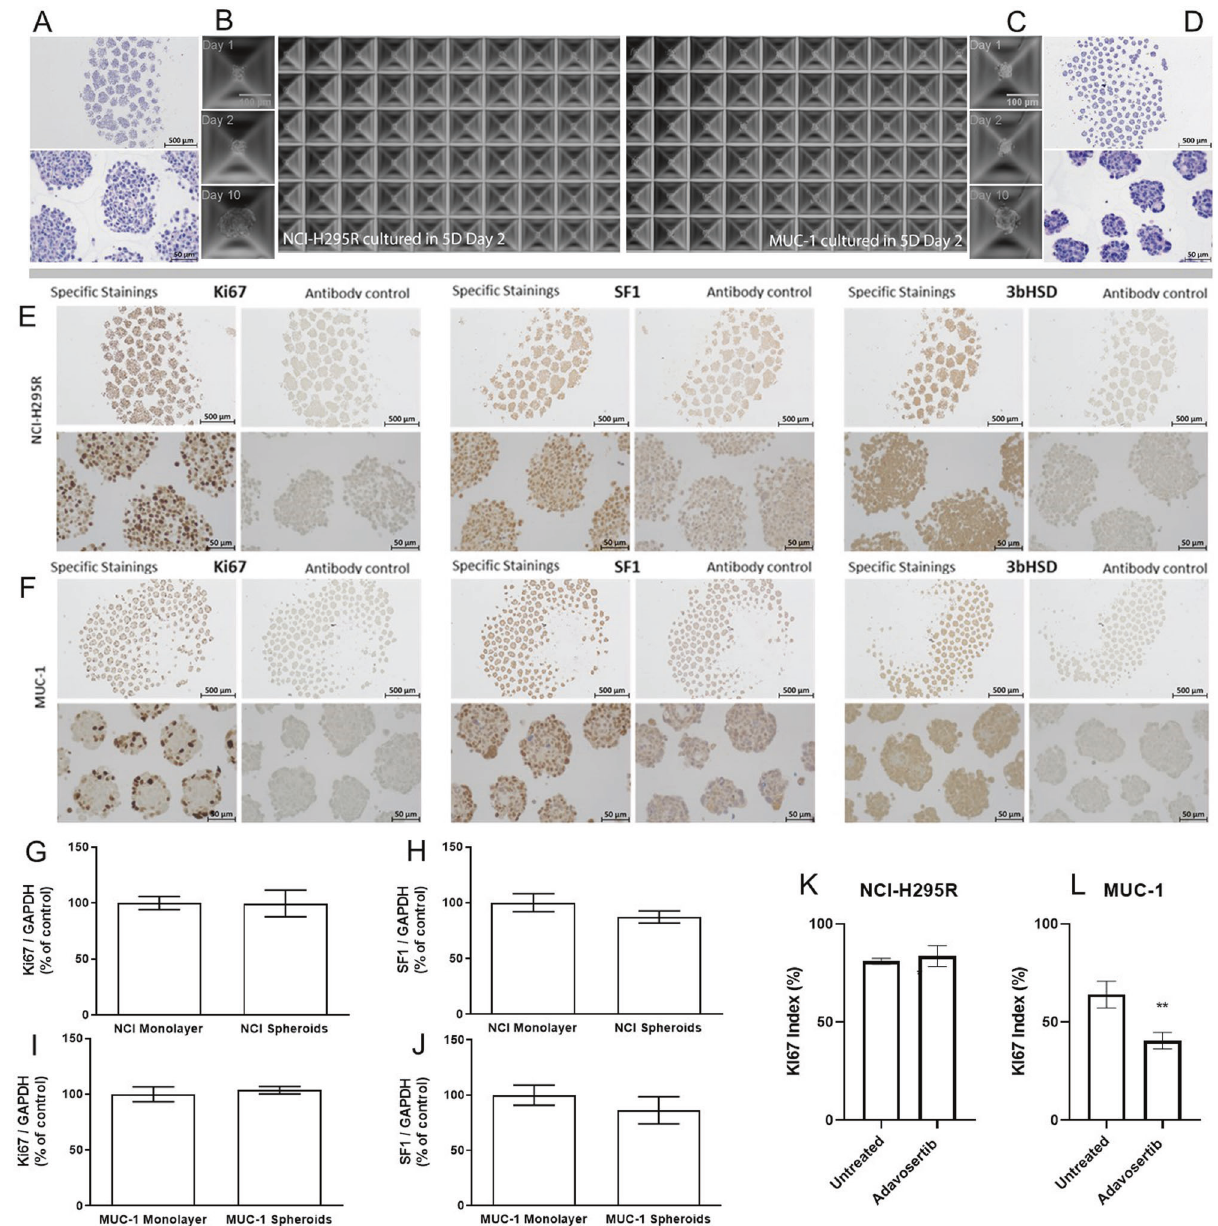
Fig. 3 NCI-H295R and MUC-1 cell lines form spheroids in the Sphericalplate 5D. H&E staining of NCI-H295R spheroids A and MUC-1 spheroids D and progression of spheroid formation B and C respectively) over 10 days. NCI-H295R spheroids E and MUC-1 spheroids F were processed for IHC with antibodies against Ki67, SF-1 and 3bHSD, scale bar 500 µm and 50 µm. Gene expression of Ki-67 G and SF-1 H was compared by real-time RT-PCR in NCI-H295R monolayer cells and spheroids ( n = 3). Gene expression of Ki67 I and SF-1 J was compared by real-time RT-PCR in MUC-1 monolayer cells and spheroids. Ki67 index between control and Adavosertib-treated NCI-H295R K and MUC-1 L spheroids. Data analyzed by Student ’ s t-test, ** p <